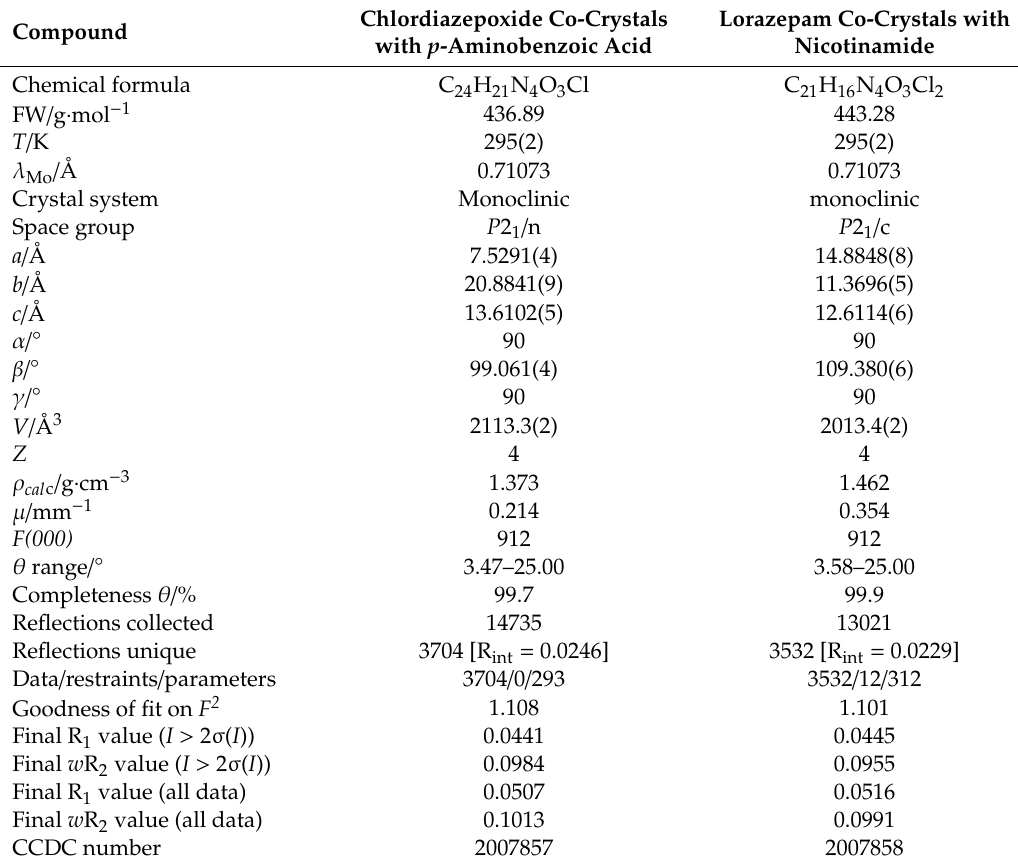
Table 1. Crystal data and structure refinement parameters for chlordiazepoxide co-crystals with p -aminobenzoic acid and lorazepam co-crystals with